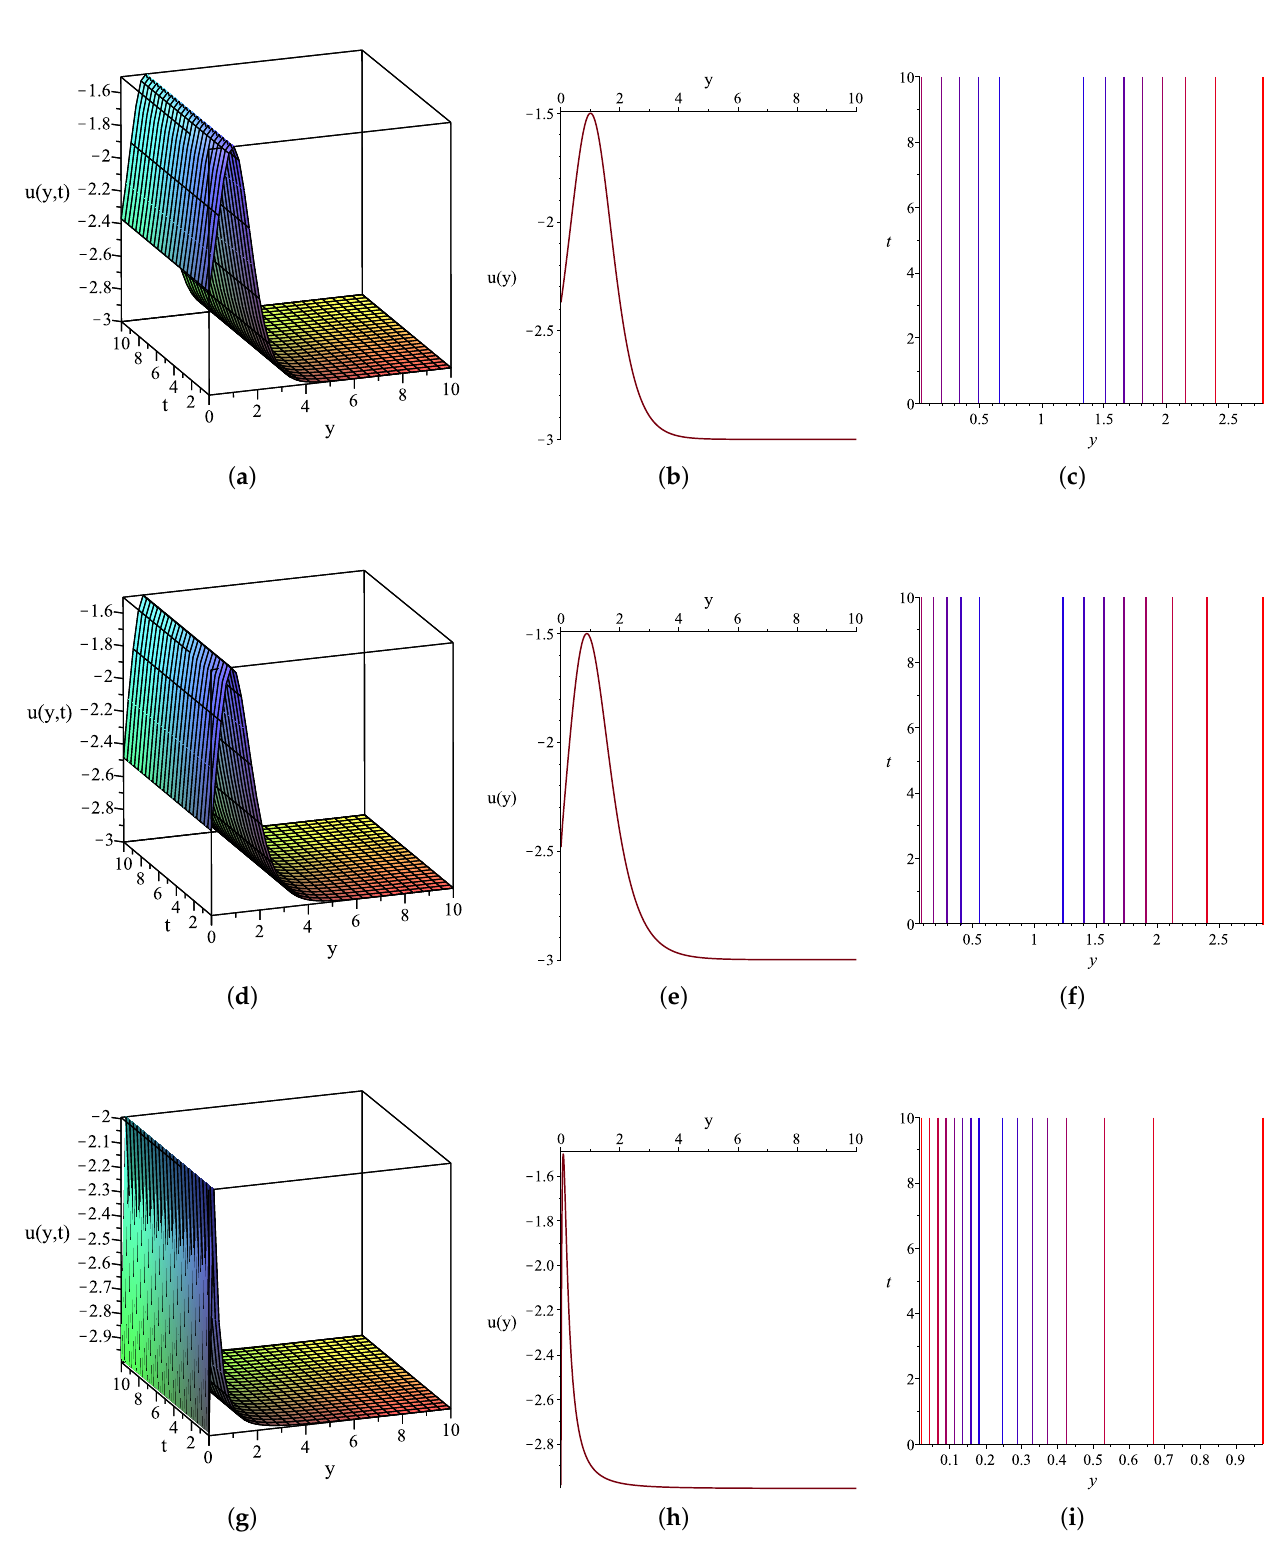
Figure 6. Associated plots of u 9 ( x , y , t ) in Equation (80) obtained using the auxiliary equation method: ( a – c ) 3-D plot, 2-D plot and contour plot, respectively when α = 1; ( d – f ) 3-D plot, 2-D plot and contour plot, respectively when α = 0.8; ( g – i ) 3-D plot, 2-D plot and contour plot, respectively when α =